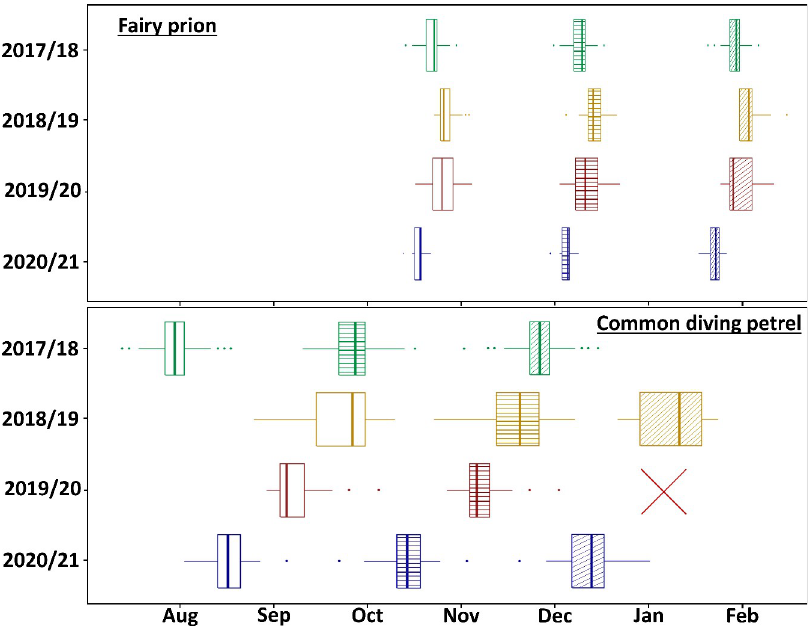
Fig 2. Inter-annual variation in the breeding phenology of fairy prions ( Pachyptila turtur ) and common diving petrels ( Pelecanoides urinatrix ) from Kanowna Island, Bass Strait, south-eastern Australia. Laying date = open boxplots; hatching date = horizontal dashed boxplots; fledging date = diagonal dashed boxplot. Laying date of CDP in 2017/18 was estimated based on mean incubation duration. Fledging date of FP in 2017/18 was estimated based on mean chick-rearing duration. Fledging date for CDP in 2019/20 was not determined because all study nests failed so no fledging data was available (red